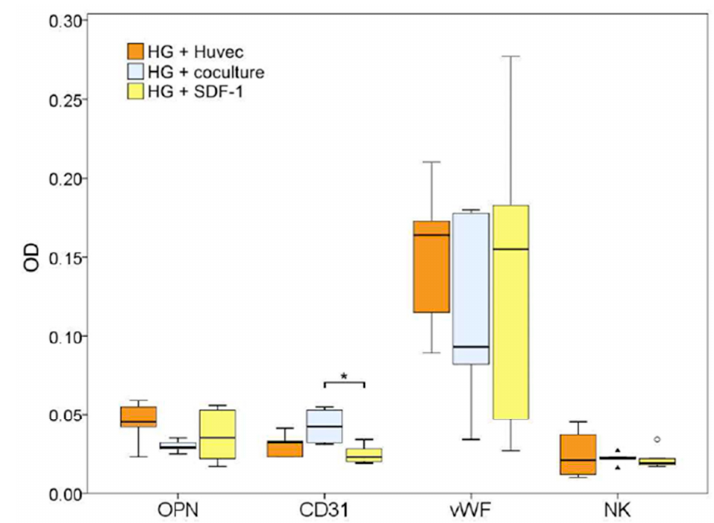
Figure 6. Quantification of immunohistological stainings for the endothelial markers von Willebrand factor (vWF) and CD31 and for the osteogenic marker osteopontin (OPN) in the groups HG HUVEC, HG co-culture (KOK) and HG SDF-1. NK = negative control. Significant differences are demonstrated by *, p ≤ 0.05.